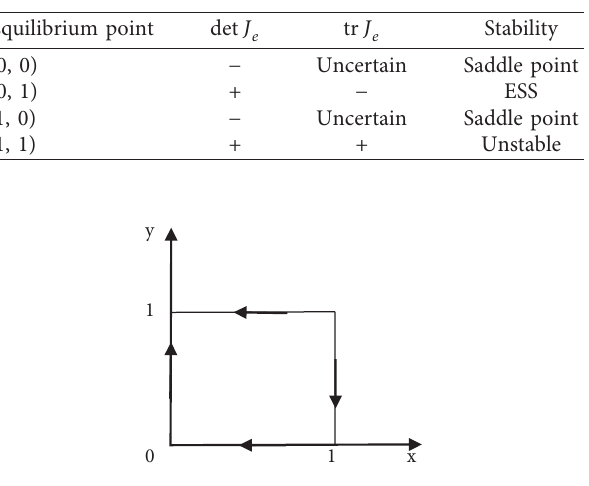
Figure 2: Game phase diagram when μ > ηβ > α and ε > ηβ − α > 0. Table 4: Analysis of partial equilibrium table.